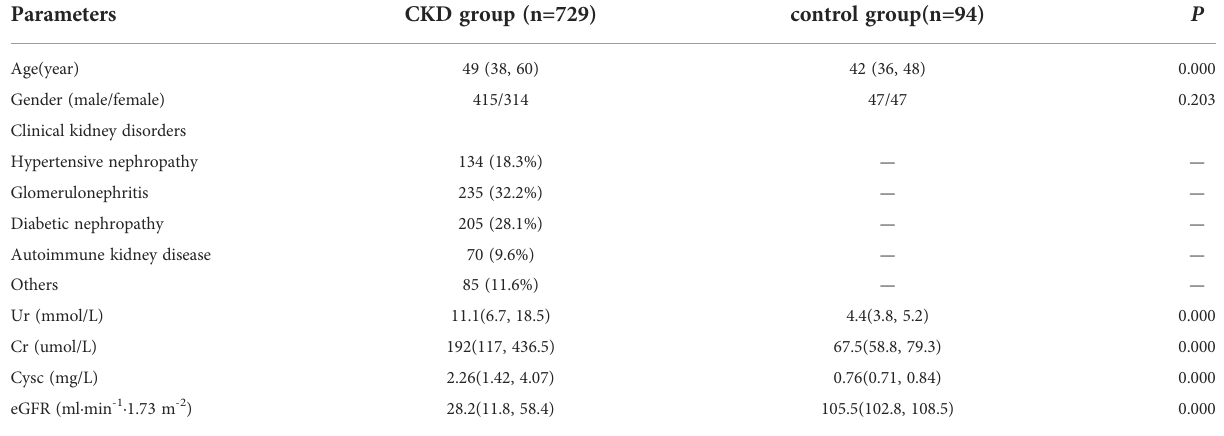
TABLE 1 Analysis of general clinical characteristics of the healthy control group and CKD